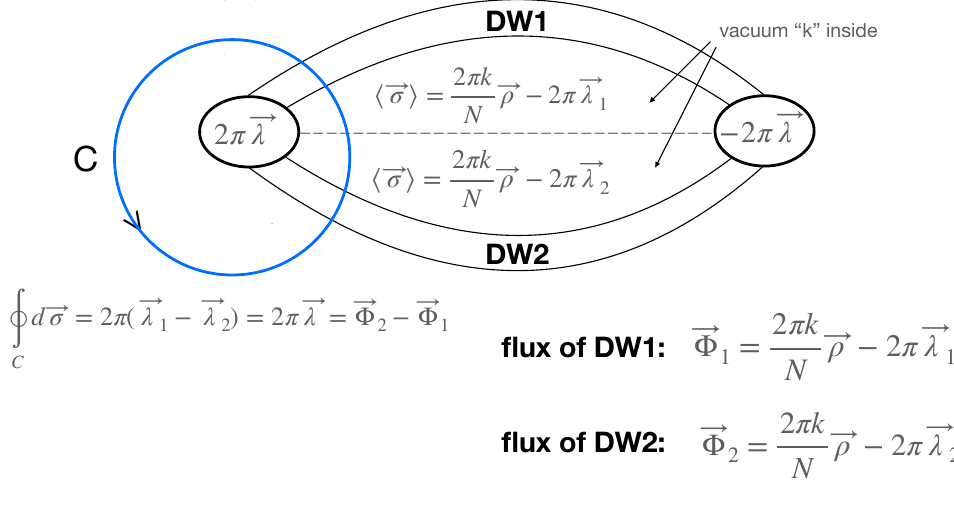
Figure 2. The double-string confinement mechanism: the static quark/antiquark sources impose monodromies of ~σ around contours C surrounding each quark. These monodromies are weight- lattice elements ± 2 π~λ = 2 πn i ~w i , n i ∈ Z . We consider, without loss of generality, strings in the vacuum h ~σ i = 0 . Due to screening by magnetic bions, chromoelectric flux can only penetrate the vacuum in thin flux tubes instead of spreading into all of R 2 . The natural candidates for such flux lines are the DWs of SYM theory, connecting vacua k units apart, h ~σ i = 0 to h ~σ i = 2 πk quarks’ flux, 2 π~λ = 2 π ( ~λ 1 − ~λ 2 ) , is then split between the flux carried by DW 1 , ~ Φ 1 = 2 π k~ρ and that of DW 2 , ~ Φ 2 = 2 π k~ρ − 2 π~λ 2 , where ~λ 1 and ~λ 2 are weight-lattice vectors. Assuming N